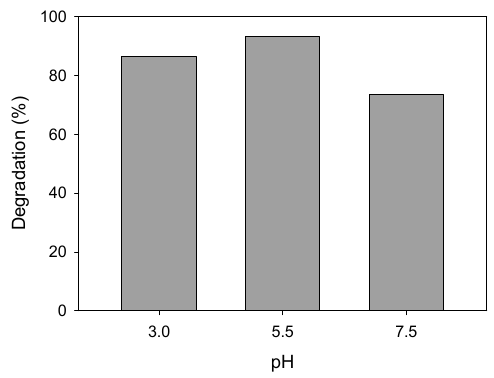
Figure 12. ATL degradation (%) at different pH aqueous solutions. Initial ATL concentration: 10 ppm; AgCl nanoparticles concentration: 0.75 g·L − 1 .